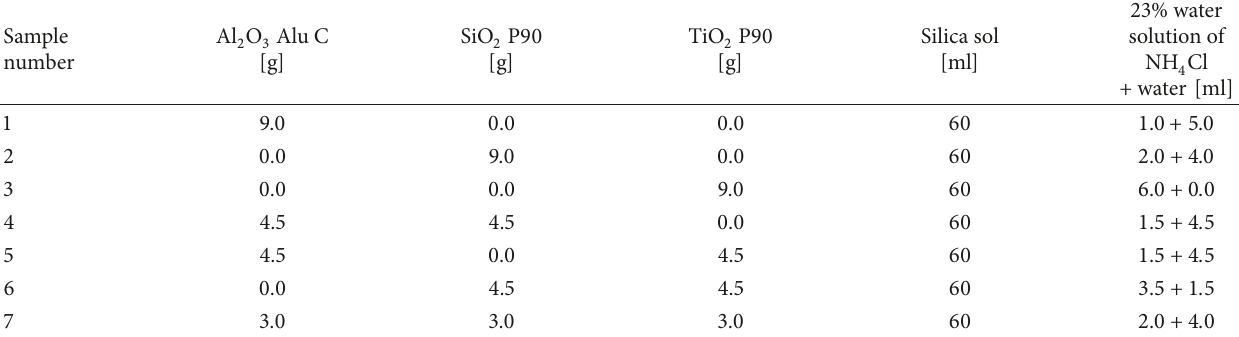
Table 2: Compositions of suspensions for silica sol-based samples (proportion: 60ml silica sol per 9 g of oxides mixture powder). Sample